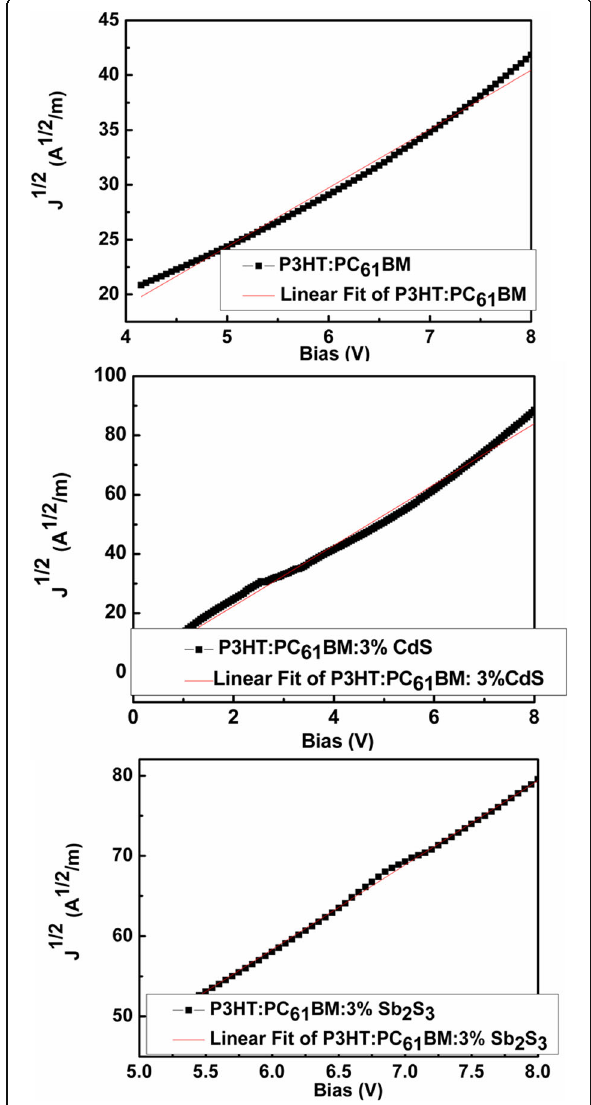
Fig. 5 J 1/2 – V curves of the hole-only devices for the devices with P3HT:PC 61 BM, P3HT:PC 61 BM:3 wt.% CdS and P3HT:PC 61 BM:3 wt.%